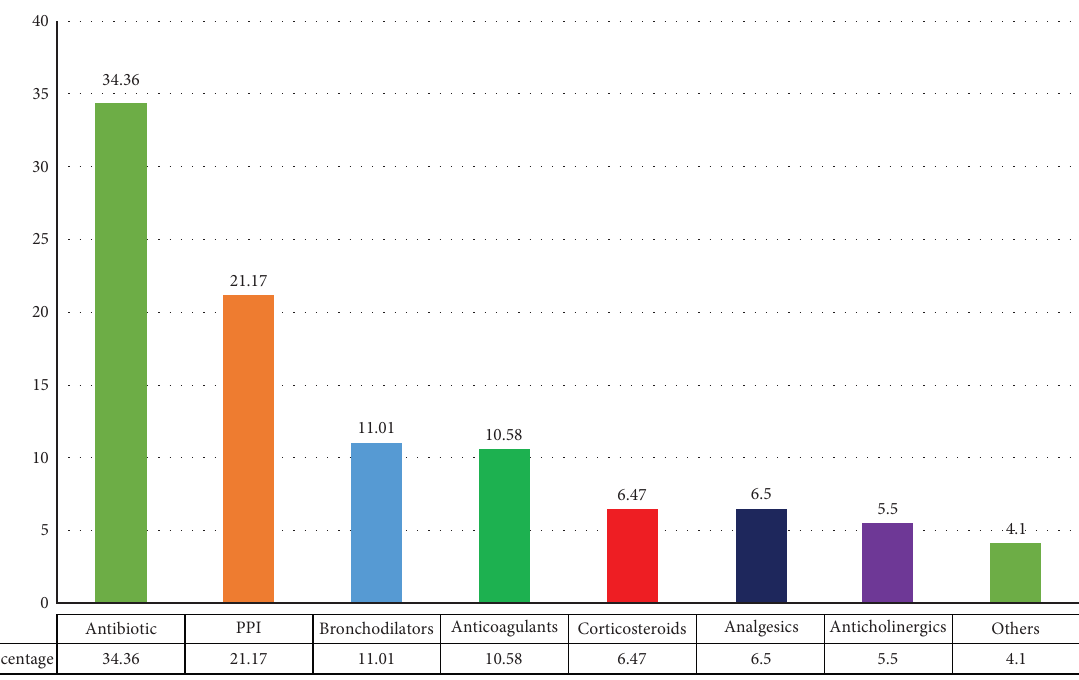
Figure 1: Most frequently used drugs during the study period ( N �